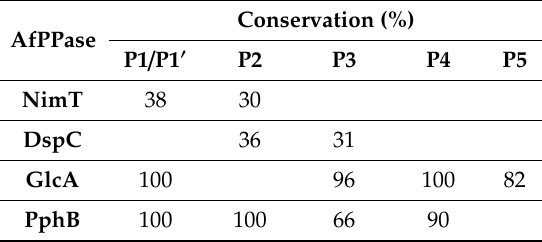
Table 3. Pocket conservation between AfPPases and human homologues. Conservation of pockets was calculated using the residues defined by PockDrug and comparing these residues to their human